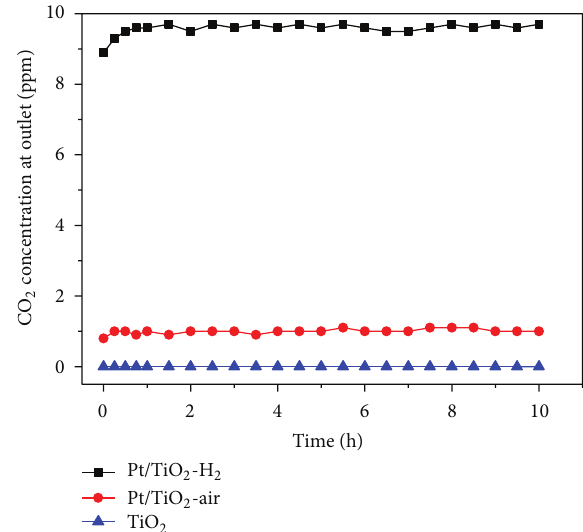
Table 1: BET surface area of Pt/TiO